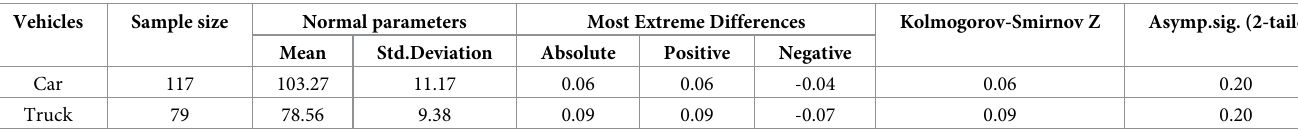
Table 2. Kolmogorov-Smirnov